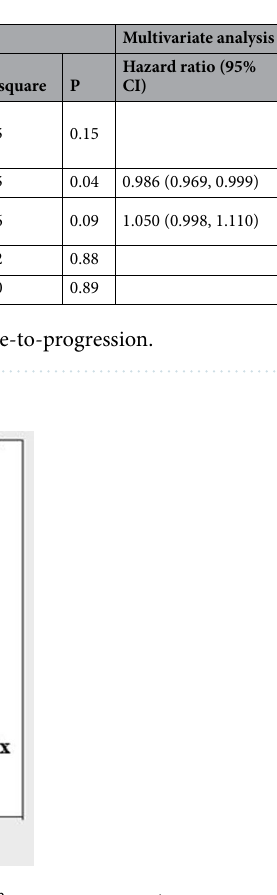
Figure 3. The linear relationship between α and α 3D values (r 2 = 0.69; p = 0.0001).